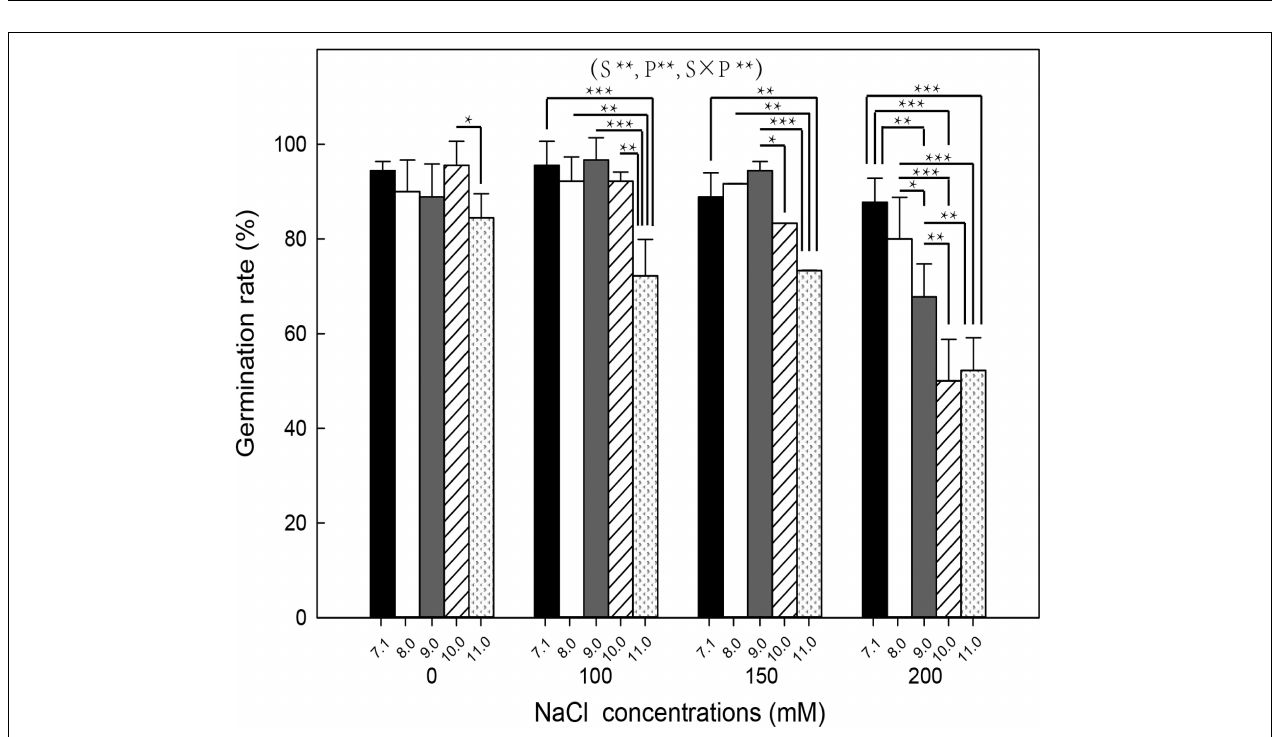
FIGURE 3 | Germination percentage of canola seeds (day 7) under combined NaCl (0, 100, 150, and 200 mM) and pH level (7.1, 8.0, 9.0, 10.0, and 11.0). S is NaCl, P is pH, and S × P is their interaction, *, **, and *** indicate significance at P = 0.05, 0.01, and 0.001, respectively, according to the least significant difference (LSD) test for simple effects analysis of two-way ANOVA interactions ( P < 0.05).